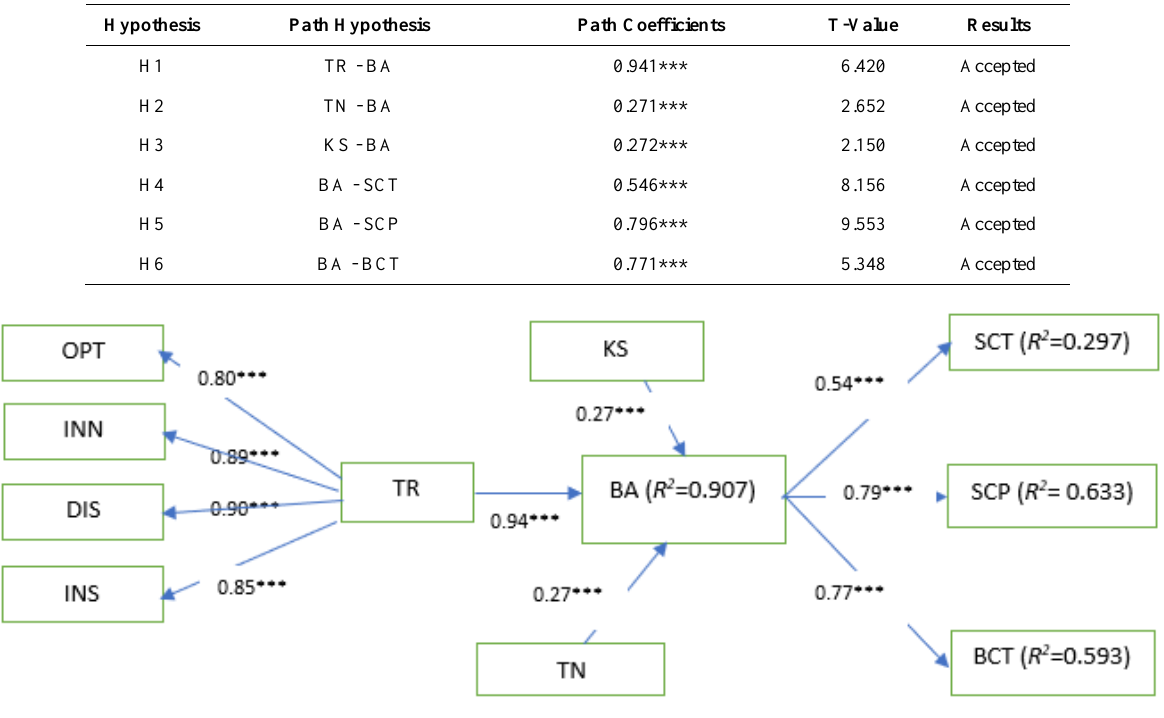
Table 6. Inner model outcome summary